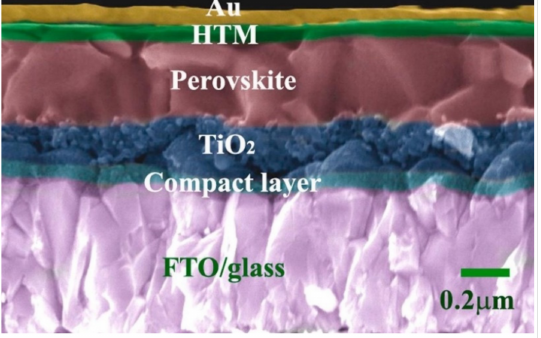
Figure 4. Representative cross-sectional image of a device based on phthalocyanine as HTM. Adapted with permission from ref [89]. Copyright 2017